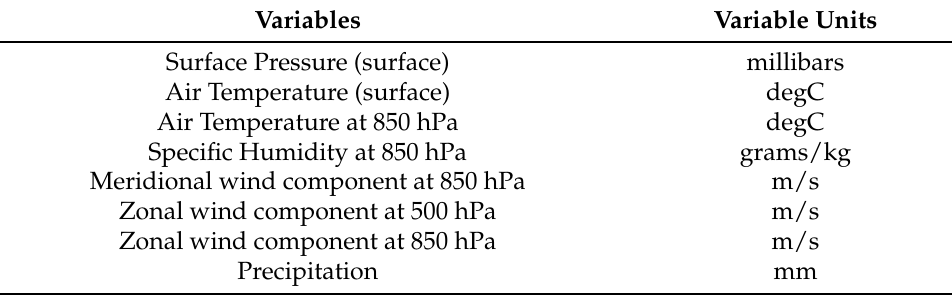
Table 3. Variables composing the